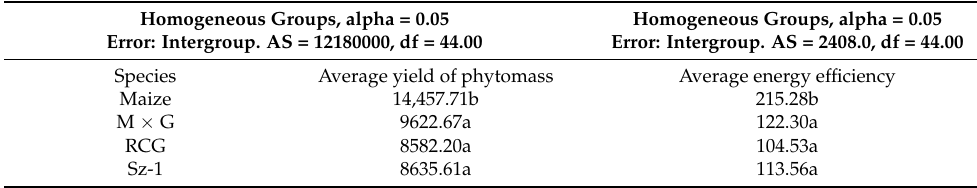
Table 10. LSD (Least Significant Difference) test: impact of species on average yield of phytomass (kg ha − 1 ) and on average energy efficiency (GJ ha − 1 ).